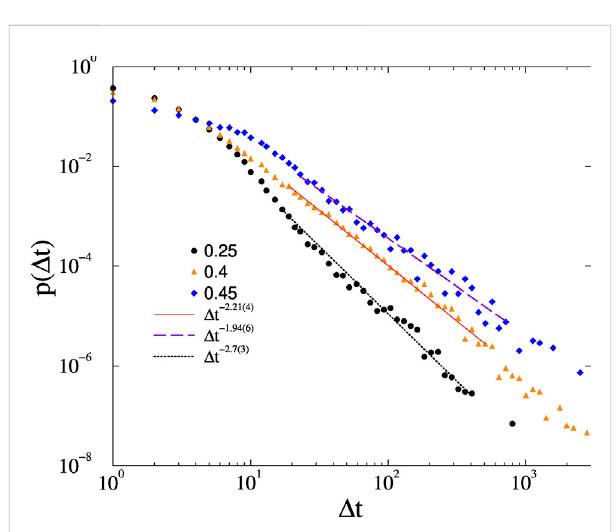
FIGURE 6 Avalanche duration distributions on the KKI-18 connectome for different forces, shown by the legends and at K = 1, ϵ = 0.01. Dashed lines are PL fi ts for Δ t >